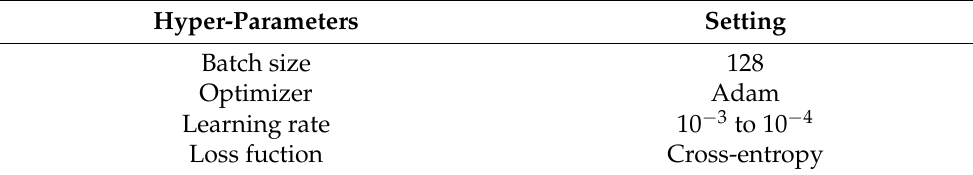
Table 1. Hyperparameters of RSE-FCN validation experiment.